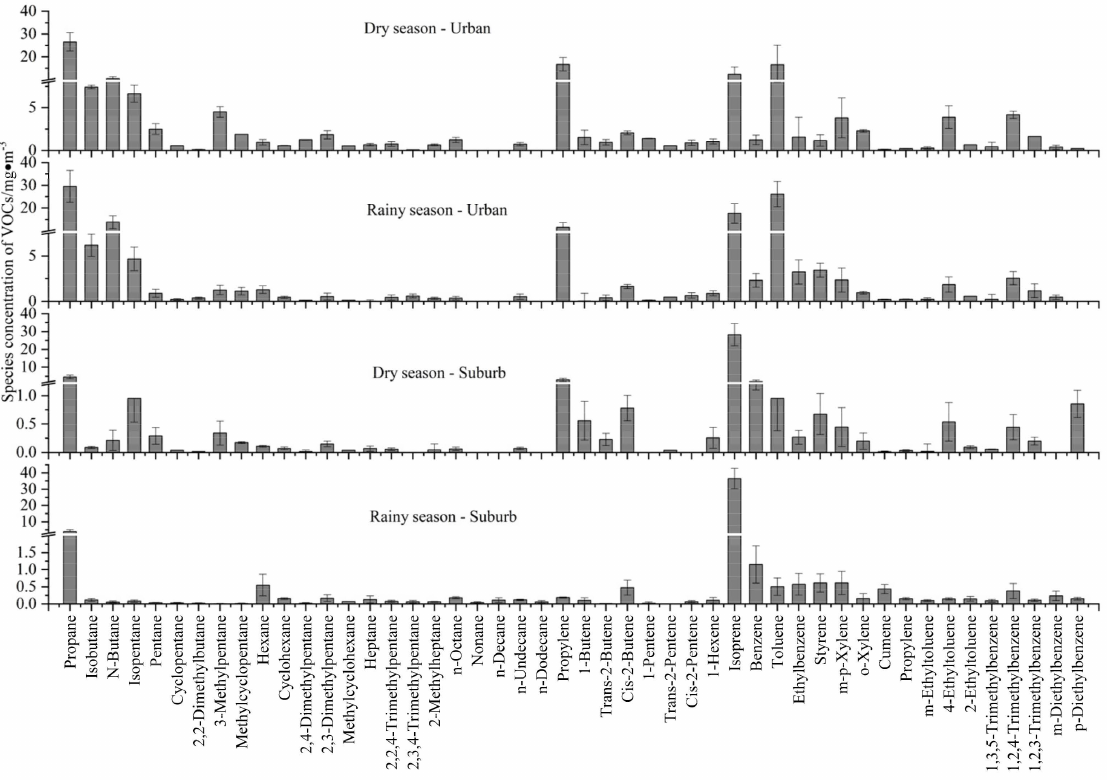
Figure 3. The level profiles of VOCs concentrations in